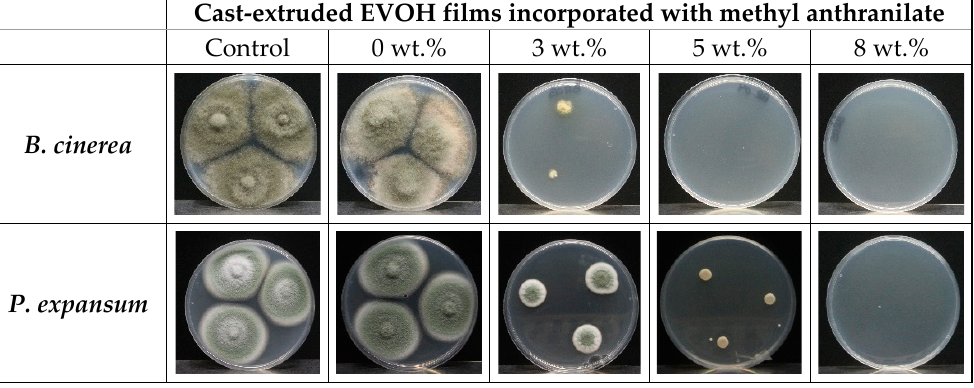
Figure 9. Visual aspect of fungal colony of P. expansum and B. cinerea co-incubated with cast extruded EVOH films incorporated with methyl anthranilate after 7 days at 26 °C.